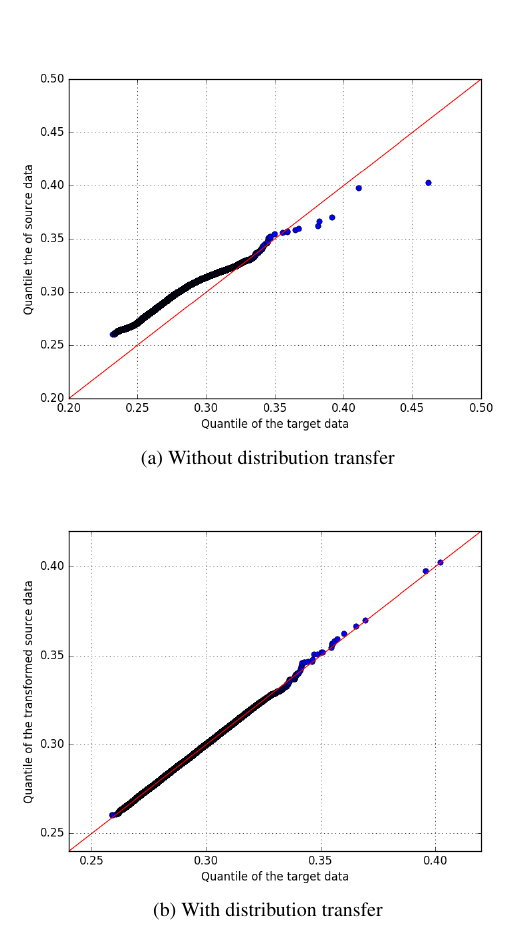
Figure 4: The Q-Q plot of the red band of images illustrated in Figure 2.